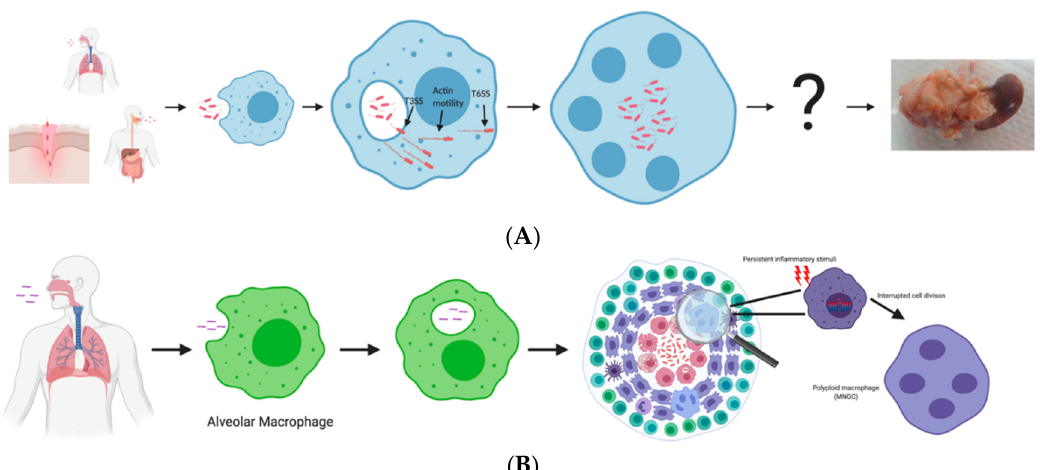
Figure 1. Comparison of pathogenesis events in Burkholderia pseudomallei ( Bpm ) and Mycobacterium tuberculosis . Bpm ( A ) enters the host through inhalation, ingestion, or percutaneous routes. Once in the host, it enters cells and escapes the endosome/phagosome via T3SS activity and becomes free in the cytoplasm. Hijacking host actin, Bpm moves to the perimeter of the cell to engage T6SS. Using T6SS activity, Bpm fuses neighboring cells and forms MNGCs and, eventually, these can establish granuloma ‐ like abscesses through an unknown mechanism. M. tuberculosis ( B ) is inhaled, where it travels into the airways and encounters alveolar macrophages. Once internalized, M. tuberculosis prevents phagolysosomal fusion and proliferates in the phagosome. Alveolar macrophages laden with bacteria penetrate the epithelium and travel deeper into the tissue, where it triggers the response that results in the formation of the granuloma. The MNGCs found within the granuloma form persistent inflammation, causing DNA damage and atypical cell division, resulting in polyploidy. Scheme of granuloma colored cells: red (macrophages; with and without bacteria, foam, and apoptotic cells), purple (epithelioid macrophages), blue (MNGCs), light purple (neutrophils), dark purple (dendritic cells), turquoise (T-cells), light blue (B-cells), green (Natural Killer cells).